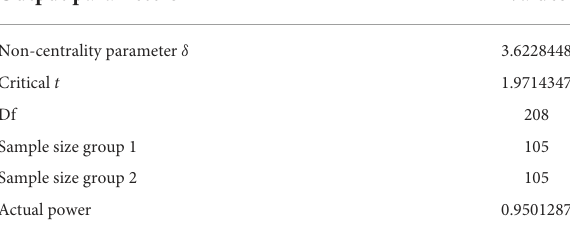
TABLE 1 The test of sample